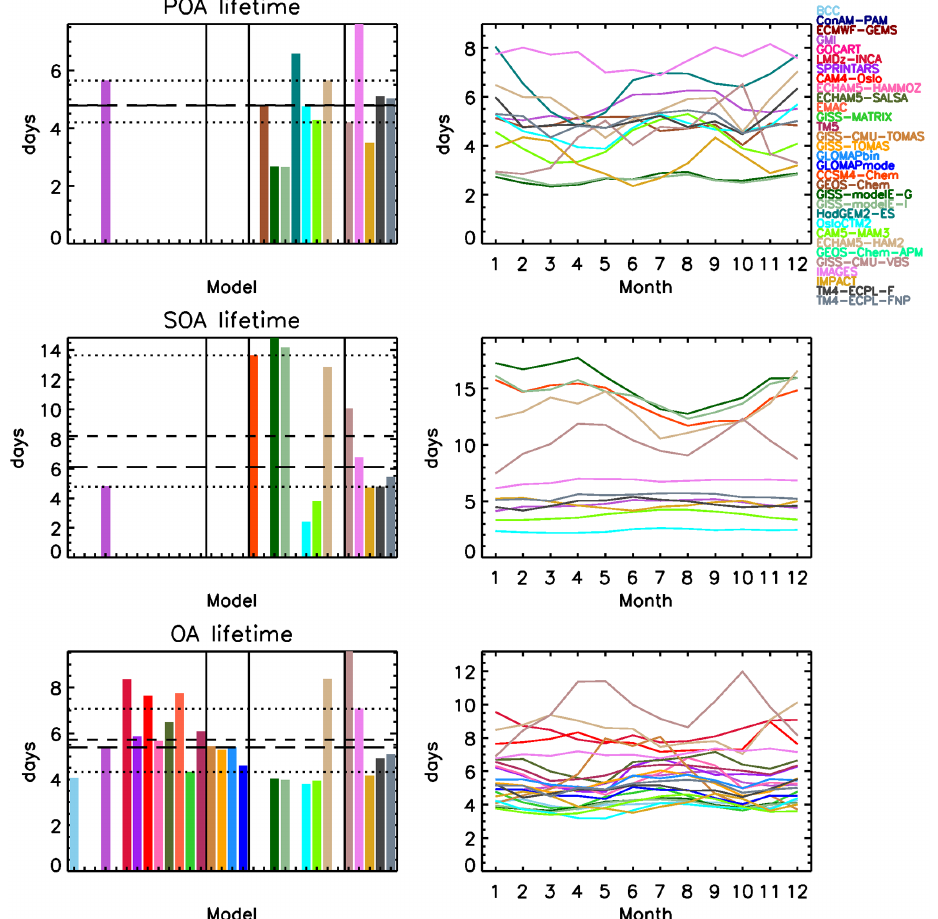
Figure 5. Same as in Fig. 2, for the POA/SOA/OA